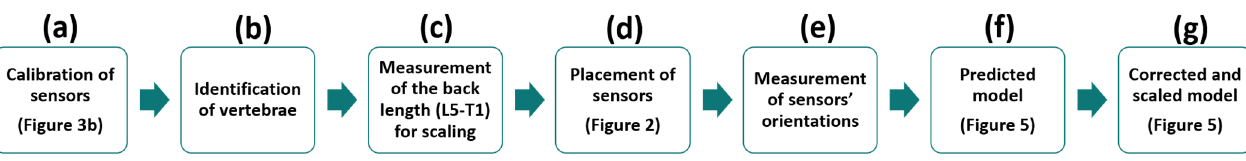
Figure 1. Flowchart of the full procedure.